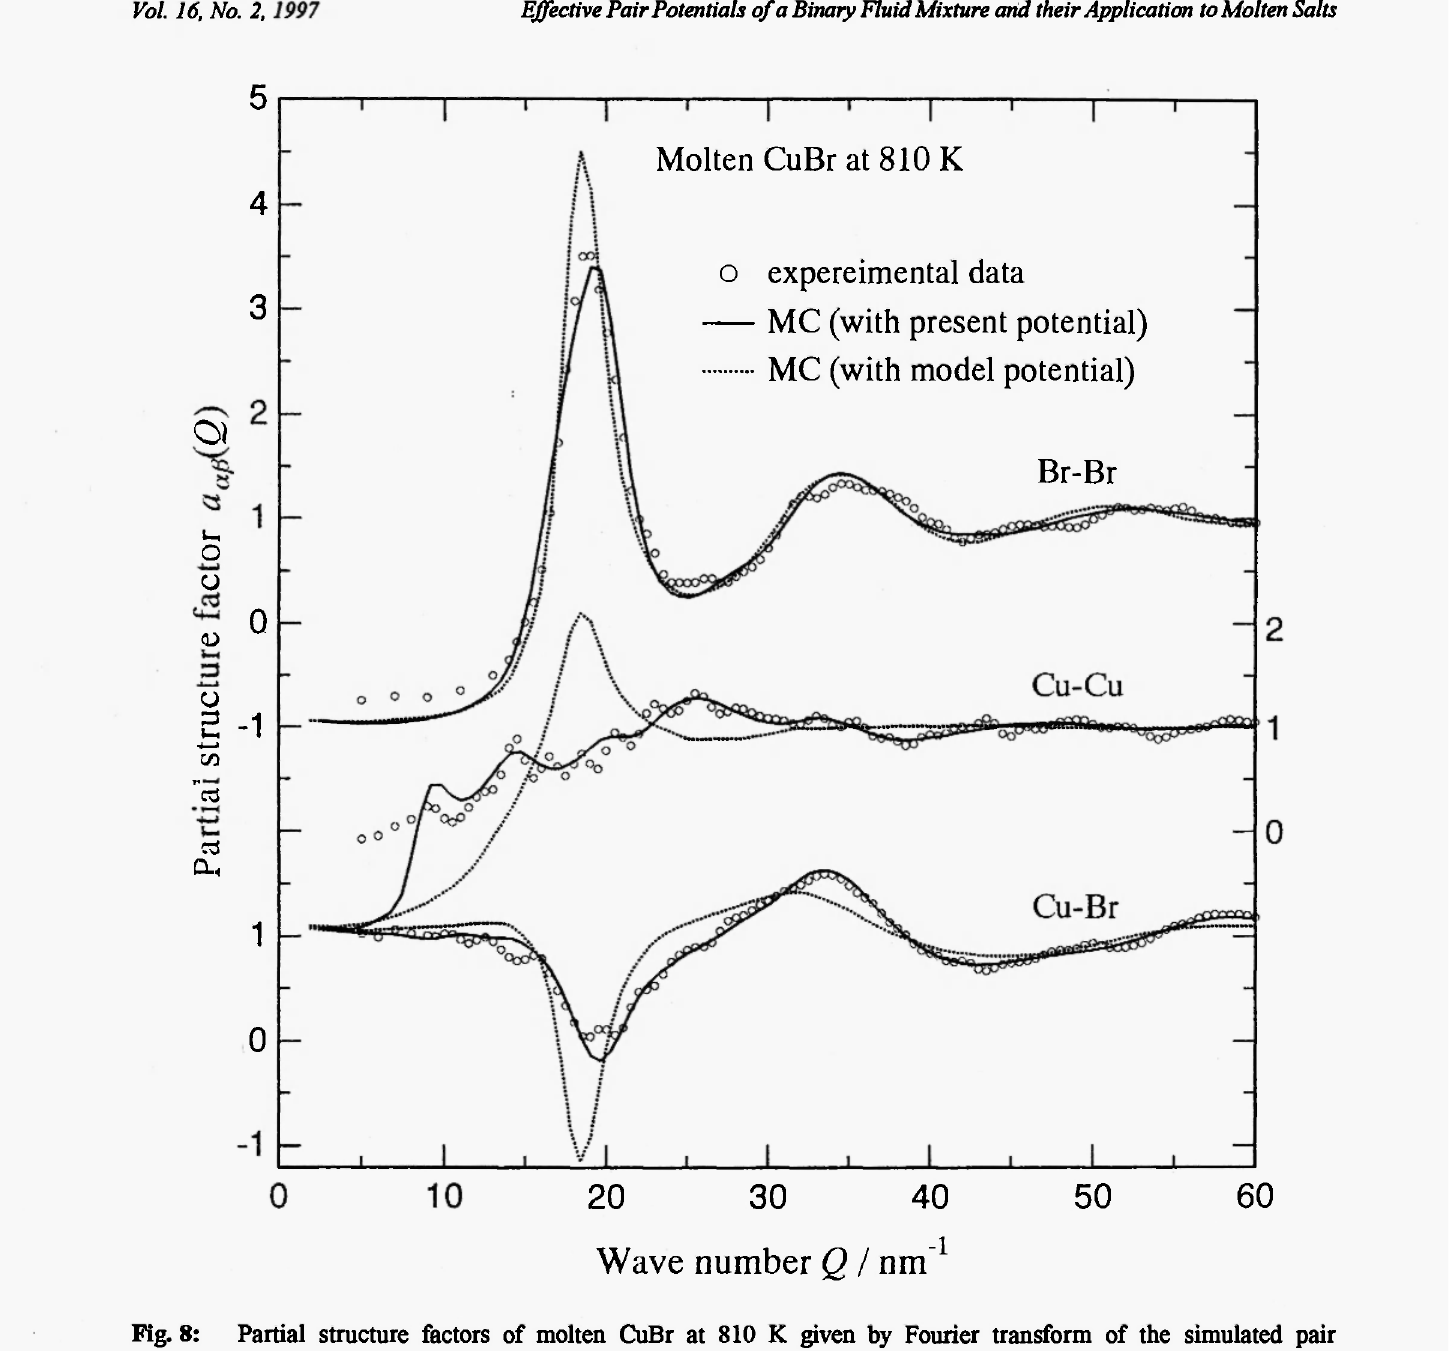
Fig. 8: Partial structure factors of molten CuBr at 810 Κ given by Fourier transform of the simulated pair correlation functions using the effective pair potentials presently obtained (solid line) and model potentials of Stafford et al. /18/ (dotted line). The experimental data (circle) are also shown for comparison. Br partial structure factor shown in Fig. 8. The present result of the Br-Br pair potential is considered, in the authors' view, rather close to the model potential and this contrasts to the Cu-Cu and Cu-Br cases. As a result, good agreement is observed for the Br-Br partial structure factor simulated with two potentials, except for the difference in the first peak